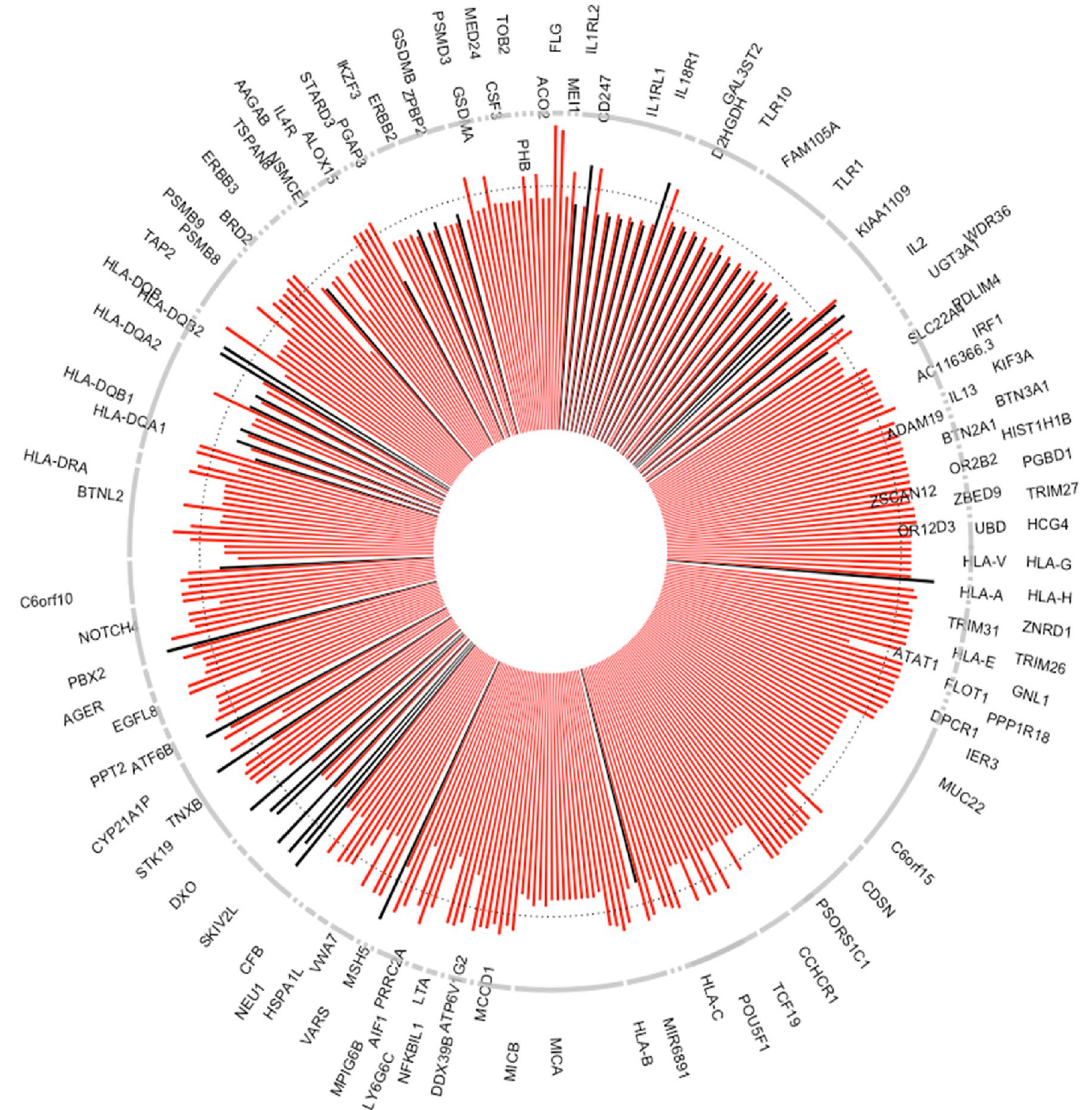
Figure 2. Exon variants of interest (N = 352) significantly associated with asthma or allergic rhinitis in the 450 K UK Biobank samples. The plot shows odds ratios of variants filter by a threshold of P ≤ 2 × 10 –9 as circular barplot where OR of 1 is indicated by a dotted line. Results for asthma are shown as red bars, allergic rhinitis as black bars. There were more variants associated with asthma than with allergic rhinitis while also number of variants per gene is highly variable with most VOI seen in MUC22 (N = 18), MICA (N = 15) and IL1RL1 (N =